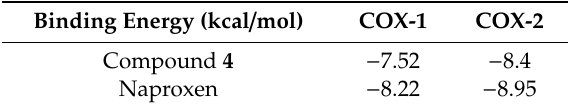
Table 2. Binding energy for the best docking conformations of compound 4 and naproxen in the binding site of COX-1 and COX-2